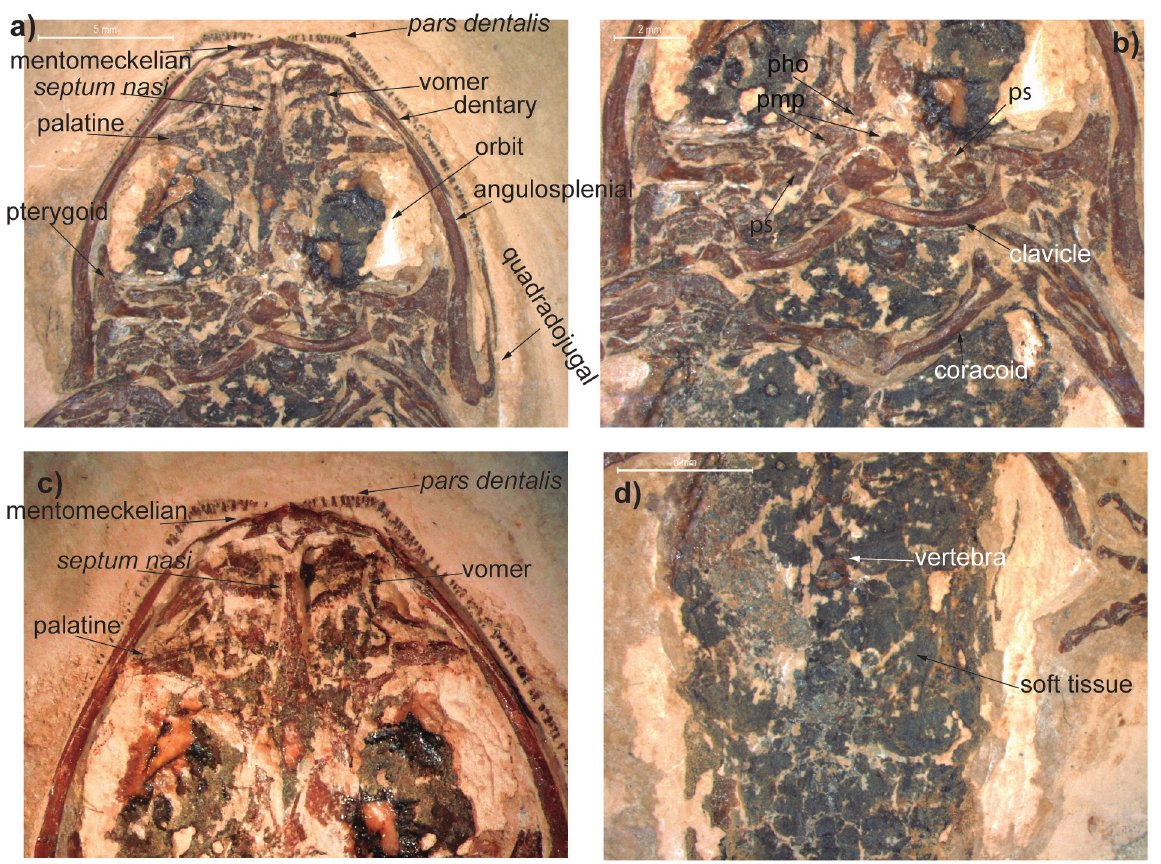
Figure 2. Primaevorana cratensis, holotype (GP/2E-9497) from Crato Formation, Lower Cretaceous (Aptian), region of Nova Olinda, Araripe Basin, Ceará state, Northeastern Brazil. a) Cranium; b) Pectoral girdle; c) Anterior portion of the cranium; d) Trunk. Photographs by Ivan Nunes. Abbreviations: pmp: posteromedial processes of the hyoid; pho: parahyoid ossification; ps: